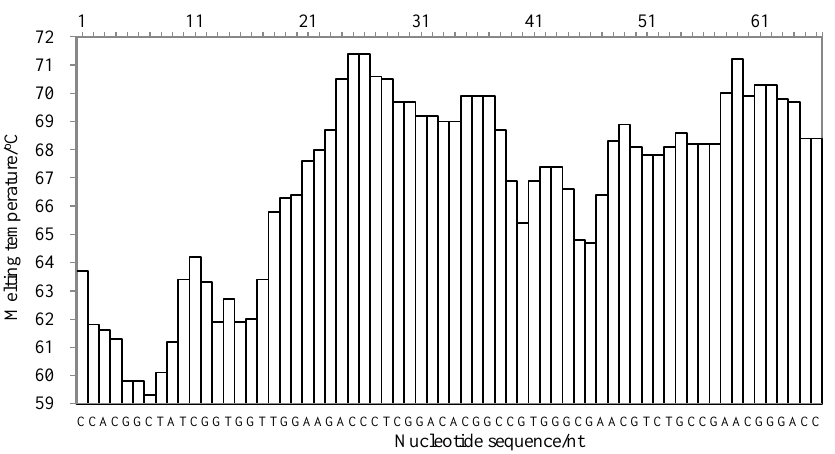
Figure 5. The melting temperature curve of the target sequence for the detection of the internal transcribed spacer of cassava using the LMTIA method.